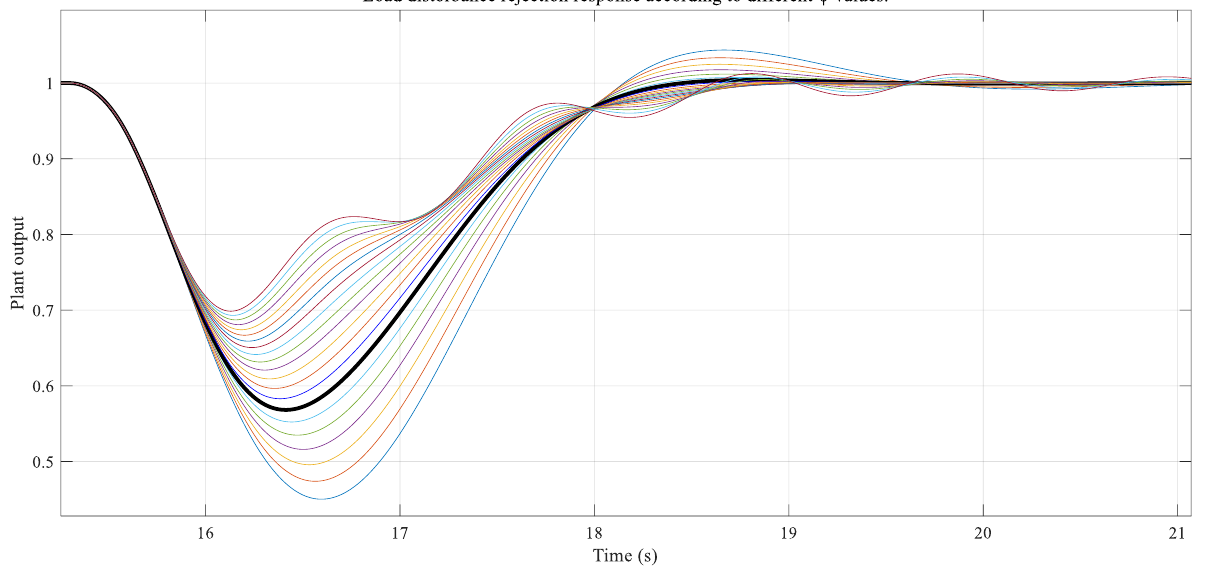
Figure 3. Load disturbance rejection response according to different ψ values.